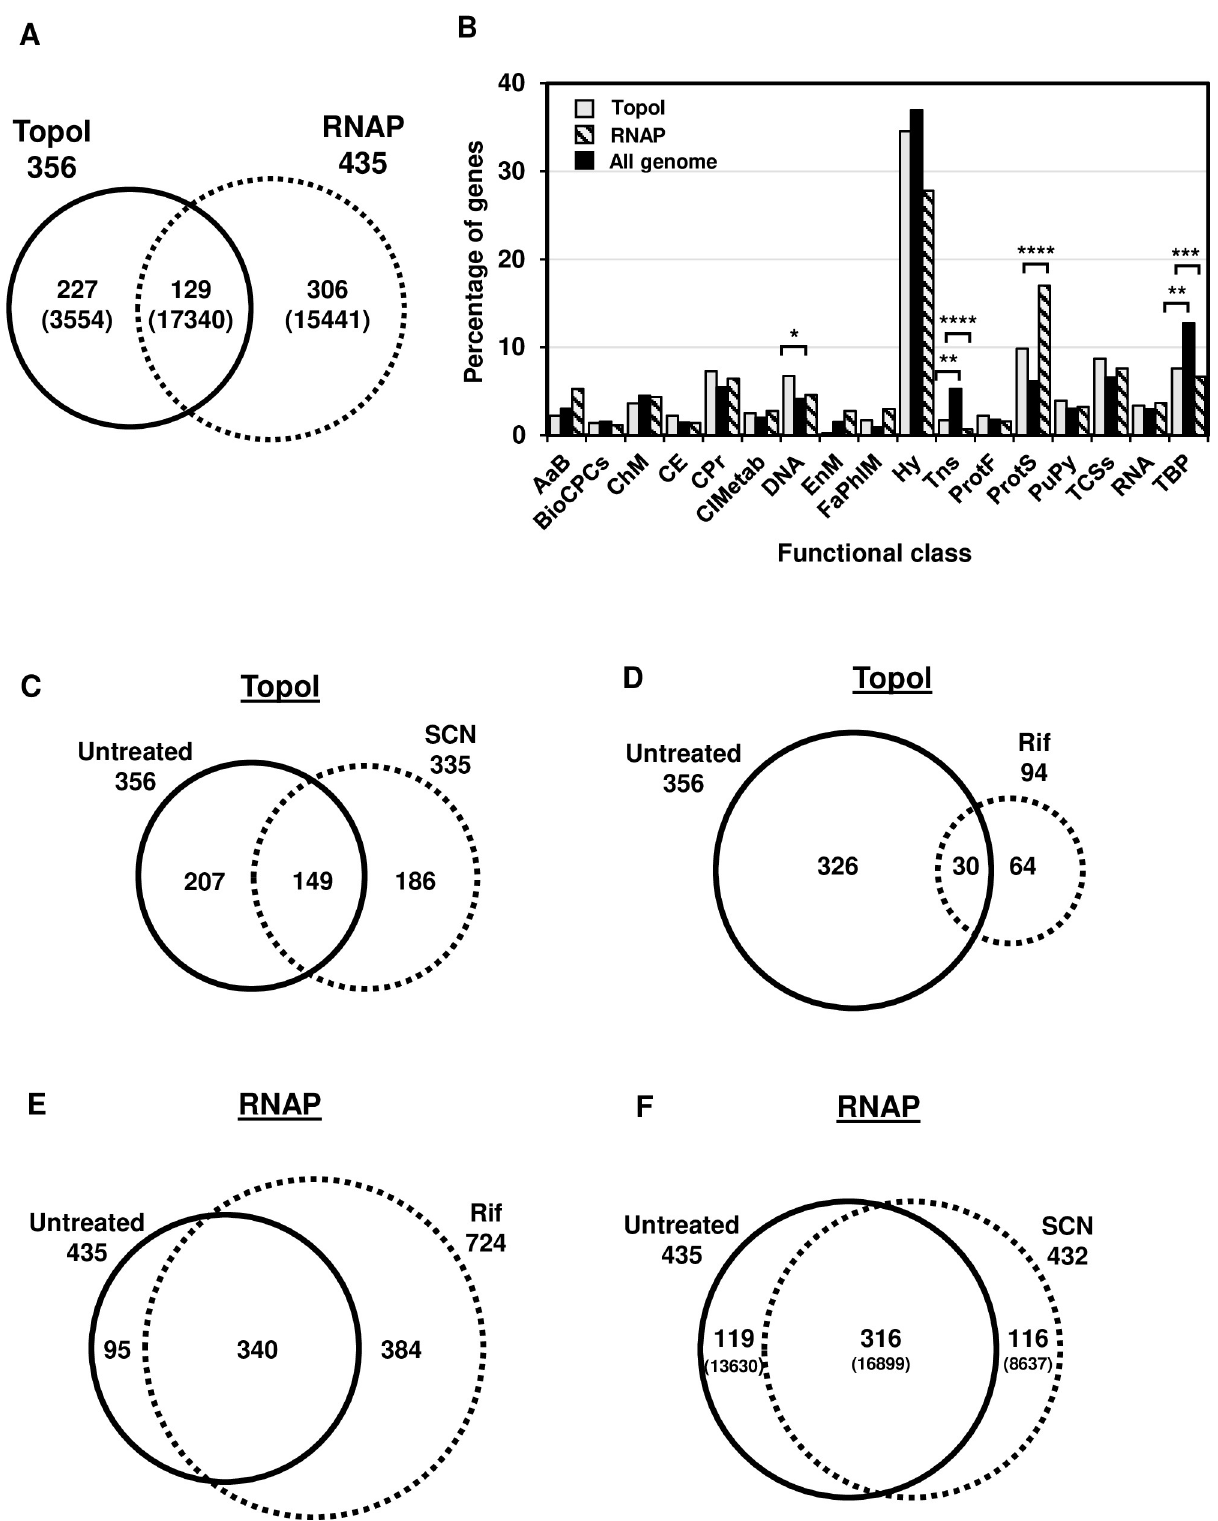
Fig 2. TopoI and RNAP enriched genes at promoter regions. A) Venn diagram representation indicating the number of promoters. Numbers in parenthesis indicate the average RPKM values. B) Classification of enriched genes by functional classes. Distribution of RNAP-enriched promoters